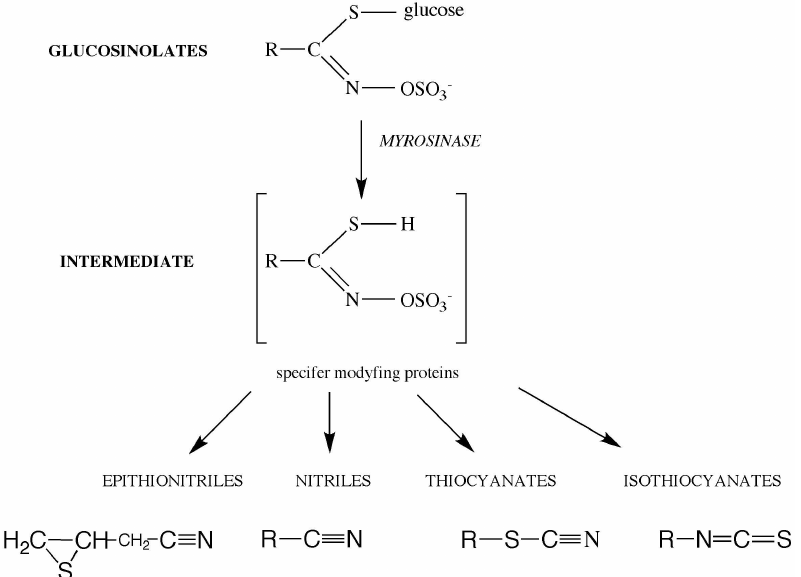
Figure 1. The products of the enzymatic hydrolysis of glucosinolates